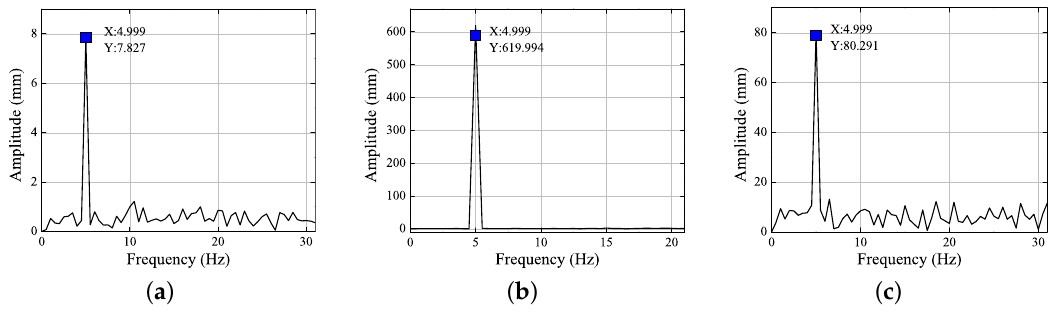
Figure 6. Frequency spectra of the right eye in ( a ) X , ( b ) Y , and ( c ) Z directions.